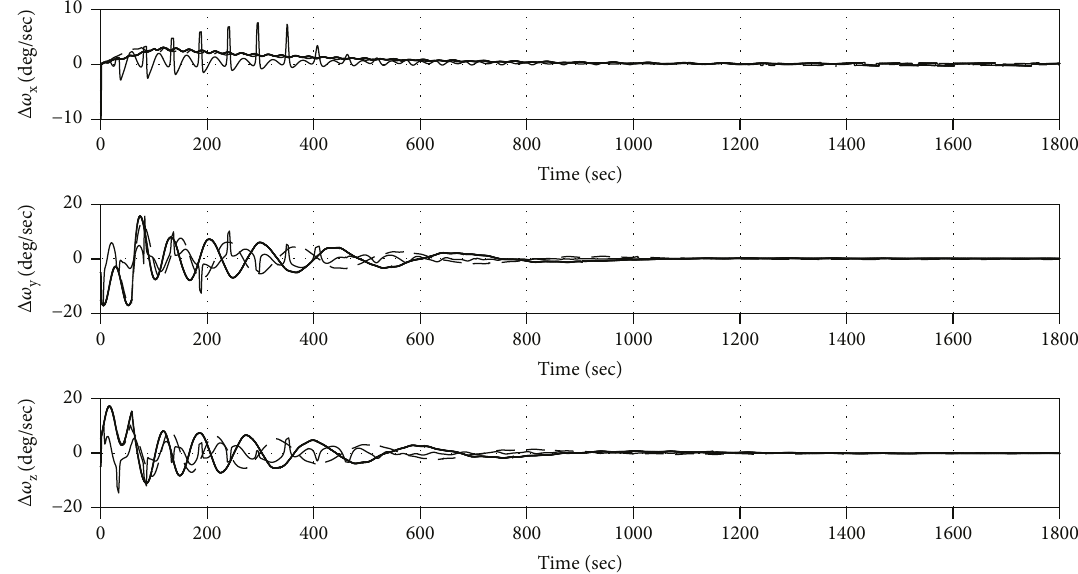
Figure 11: Measurement errors for 1Hz (solid line), 8 Hz (dashed line), and 10 Hz (dotted line) sampling rates.